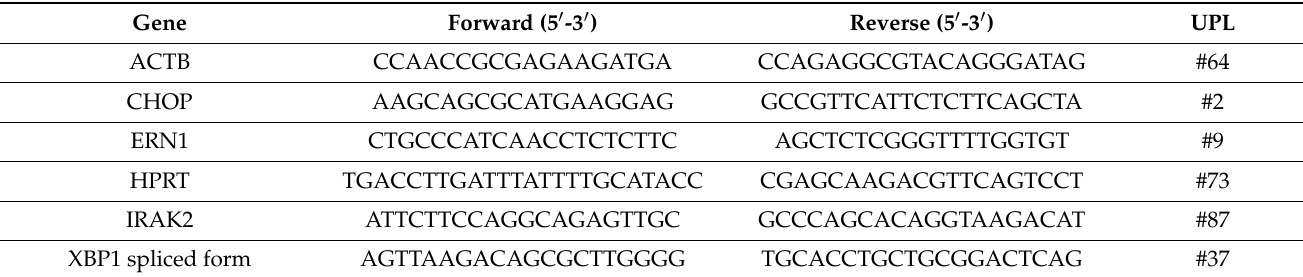
Table 1. Primers and universal probe library (UPL) probes used in qPCR